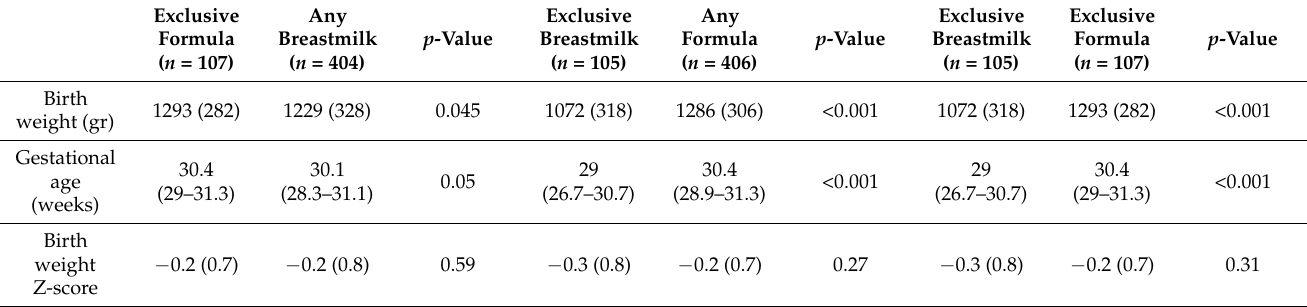
Table 3. Demographic and clinical characteristics of breastmilk fed infants vs. others. (Israel,